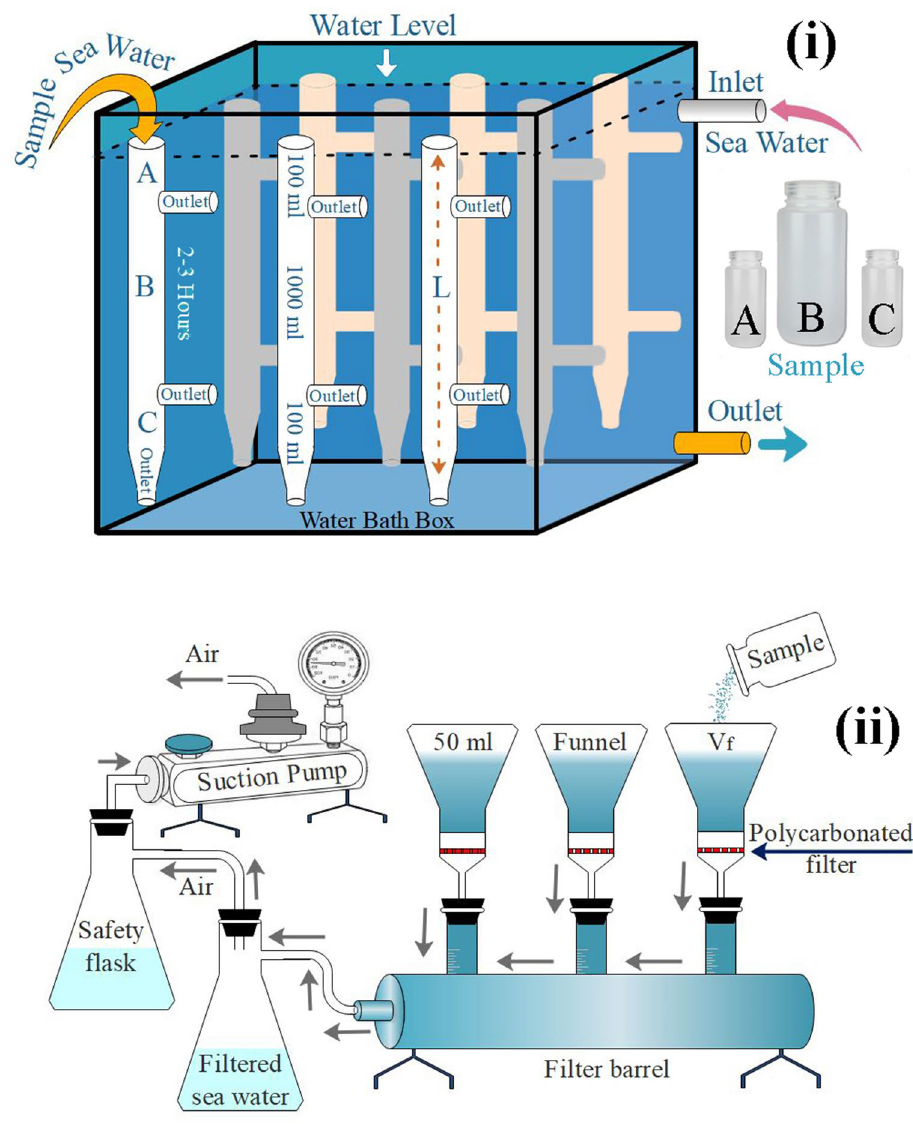
Figure 11. SETCOL setup ( A ) of the vessel and batch filtration processes of colloidal TEP ( B ) according to the literature (Drawn by Dr. M Shahanul Islam, 1st